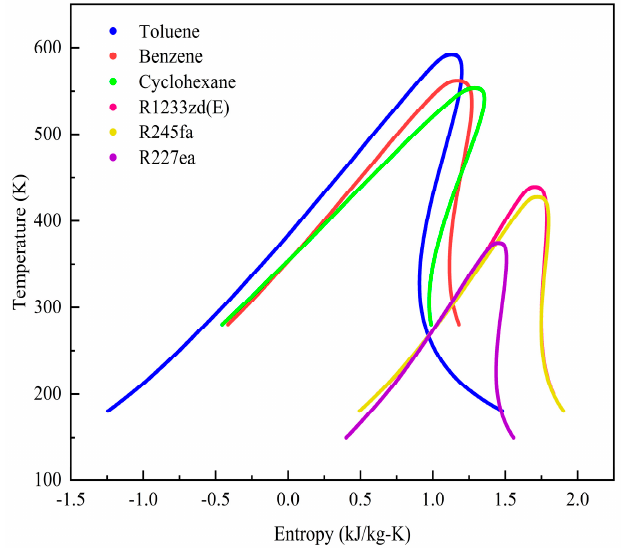
Figure 4. T-s diagram of the working fluids. Table 2. Properties of the working fluids.